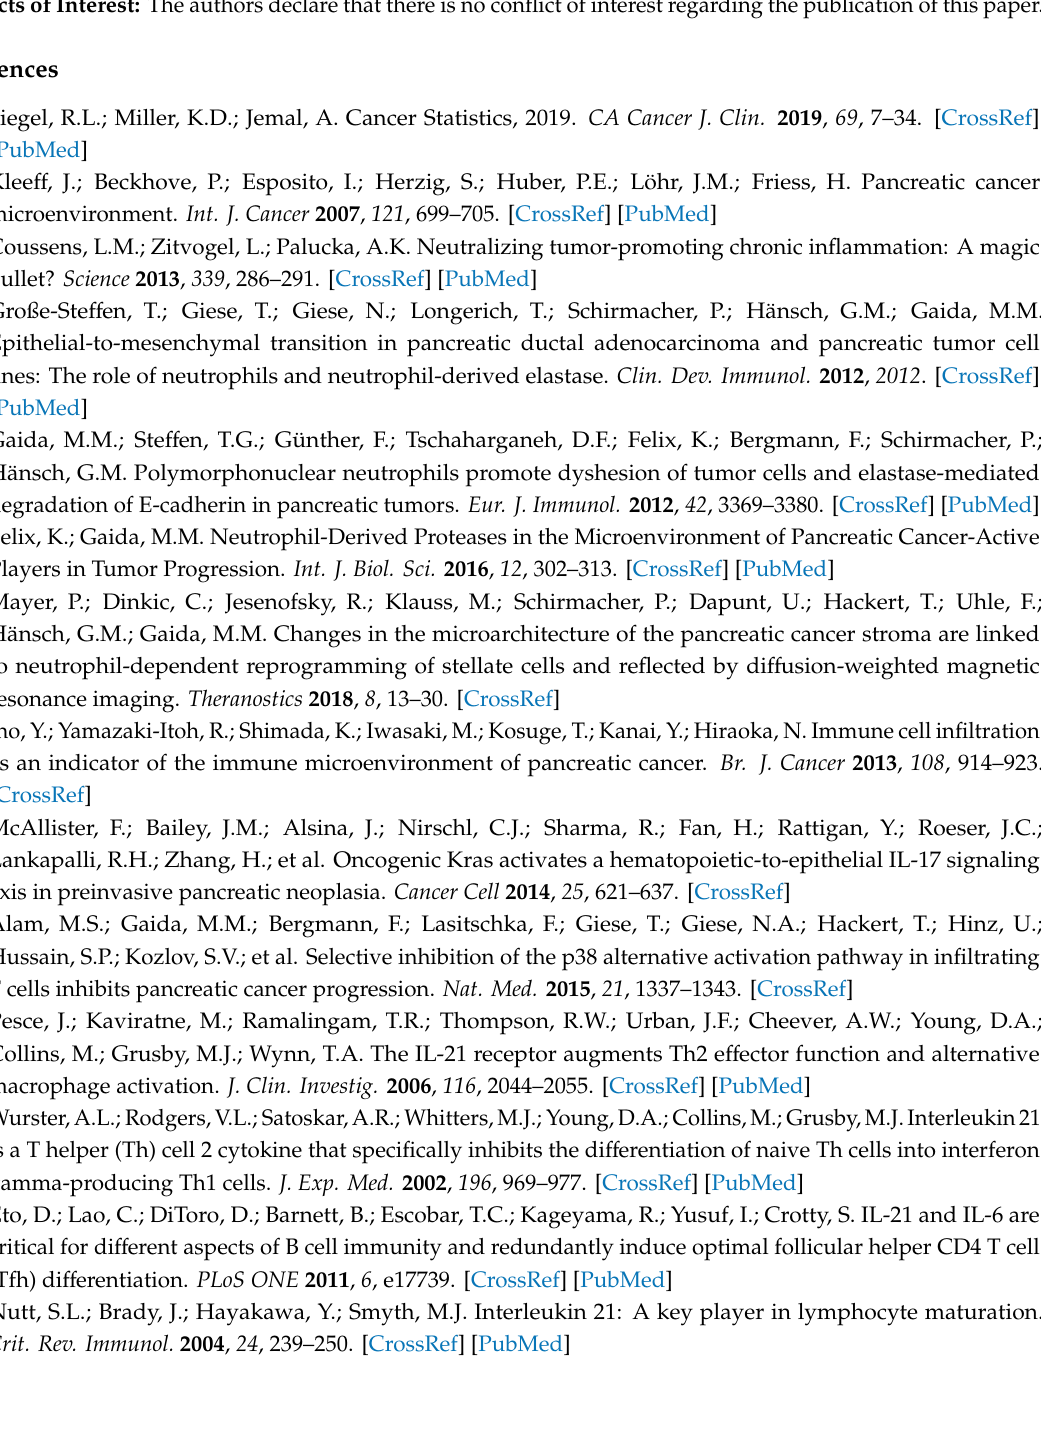
on Blimp-1 sites, Figure S5: Dox-inducible Blimp-1 overexpression, Supplementary Table S1: Oligonucleotides for sgRNA cloning, Table S2: Primers for cloning, Table S3: Primers for T7 endonuclease